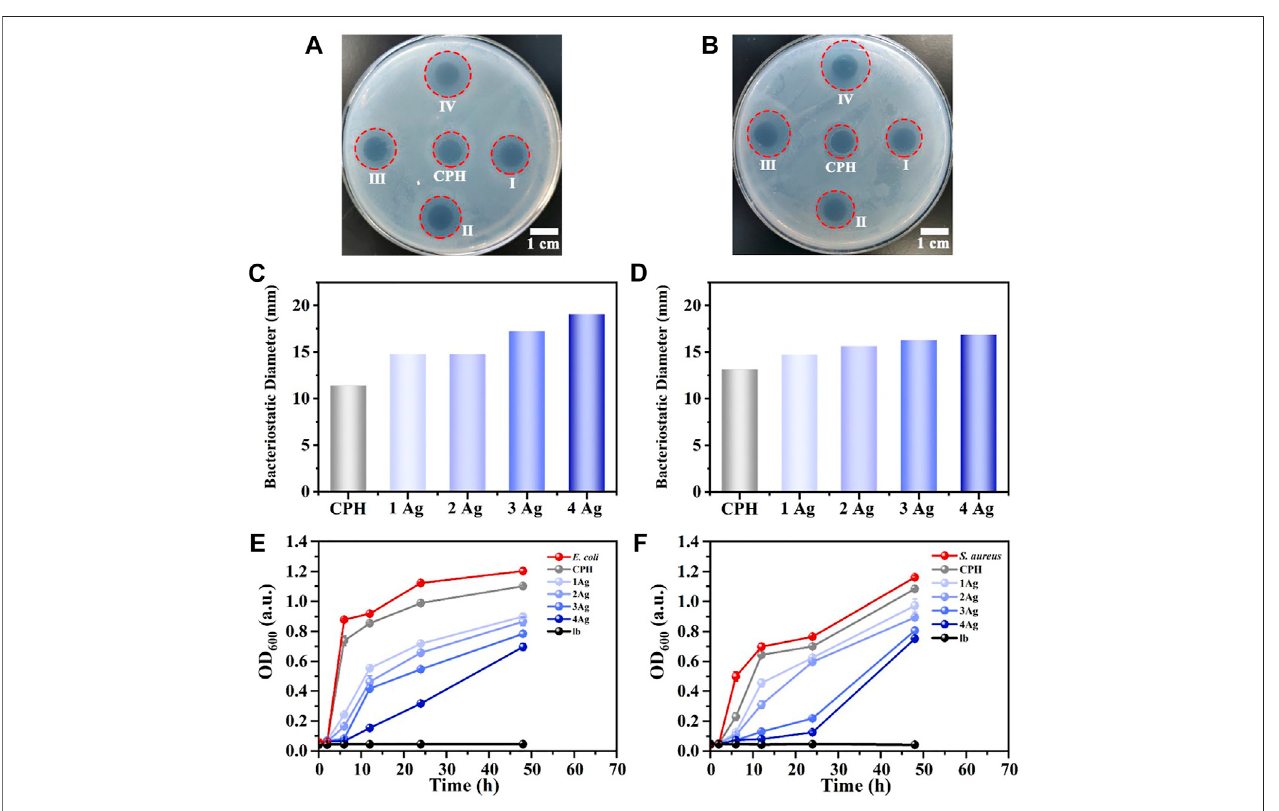
FIGURE4 | (A,B) show the photos ofthe antibacterial plate experiment ( E.coli and S. aureus ) for Ag NPs/CPH. In the photos, I denotes the 1 Aggroup, IIdenotes the 2 Ag group, III denotes the 3 Ag group, and Ⅳ denotes the 4 Ag group. (C,D) show the calculated diameter of the inhibition zone of the corresponding antibacterial plateexperiment. (E) ODvaluediagramofthelbmedium,CPH, E.coli solution,and E.coli cocultureswithAgNPs/CPHatdifferentconcentrationsofAgNPs(1Ag,2Ag, 3 Ag, and 4 Ag) from 0 to 48 h. (F) OD value diagram of the lb medium, CPH, S. aureus solution, and S. aureus cocultures with Ag NPs/CPH at different concentration of Ag NPs (1 Ag, 2 Ag, 3 Ag, and 4 Ag) from 0 to 48